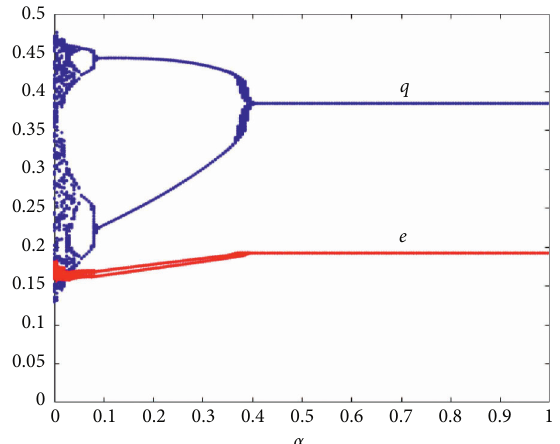
Figure 16: The bifurcation diagram of the controlling factors δ , when λ � 0 .